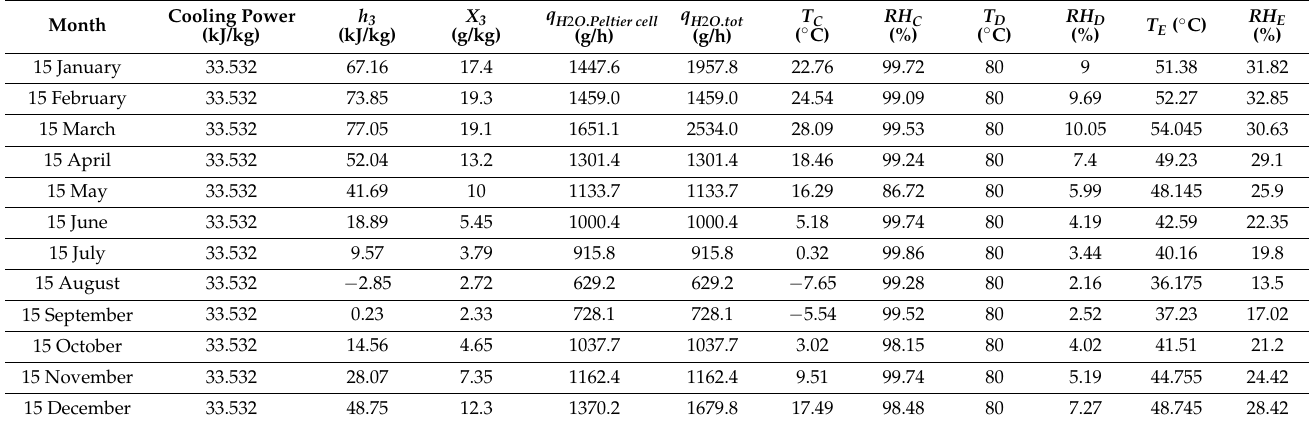
Table 7. Calculation of condensed water using 5 Peltier cells.